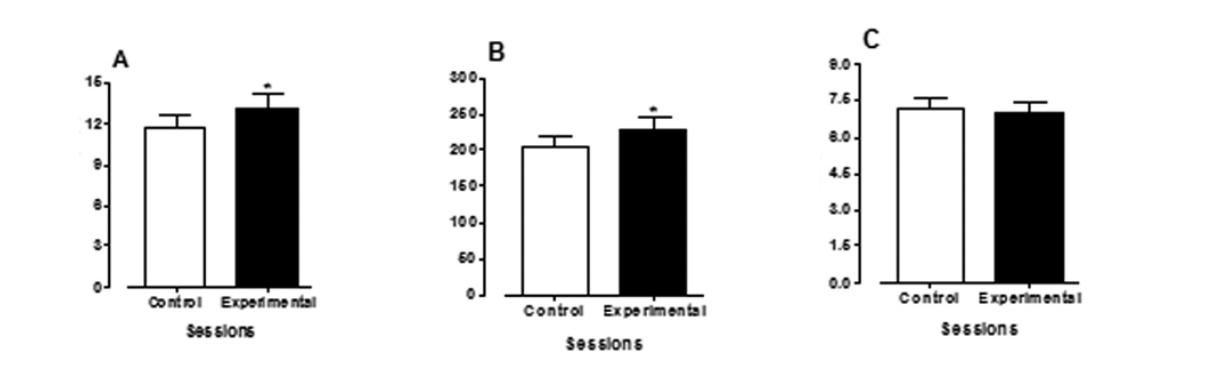
Figure 2. Means and standard deviation of the following dependent variables. A: maximum number of repetitions at 75%1RM; B: training volume; C: RPE in both conditions (control and experimental); *Significant differences between Experimental and Control ( p <